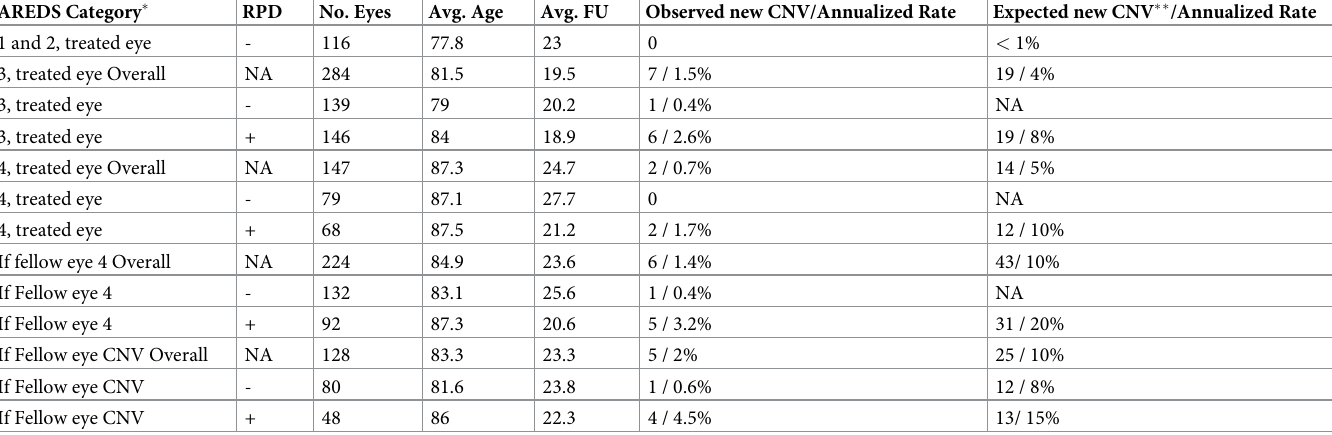
AREDS Cat = age related eye disease study simplified disease categorization scale. RPD = reticular pseudodrusen. GA = geographic atrophy. No. = number. Avg. = average. FU = length of postoperative follow-up, in months. CNV = choroidal neovascularization. Annualized rate = number of new CNV observed divided by months of follow up times 12. Unilateral = Expected = rate of new CNV for this category (if applicable, as RPD not identified) estimated from the AREDS. As the AREDS did not distinguish geographic atrophy (10% of advanced cases) from CNV (90% of advanced cases) in the outcome of category 3 eyes, the expected CNV rate from the AREDS is arrived at by multiplying the incidence of advanced AMD x 0.9. NA = not applicable as RPD not identified in the AREDS. (cid:3) For AREDS categories 2–3, assumes fellow eye is category 3 or better. (cid:3)(cid:3) Estimated for eyes with RPD by multiplying AREDS rate x 2 in eyes without fellow eye CNV. For eyes with fellow eye CNV, CATT (Comparative of Age-related macular degeneration Treatment Trial) data accounting for RPD is used. None of these new CNV incidence estimates adjust for patient age; median age this study 84 years; AREDS 69 years; CATT study 79 years.